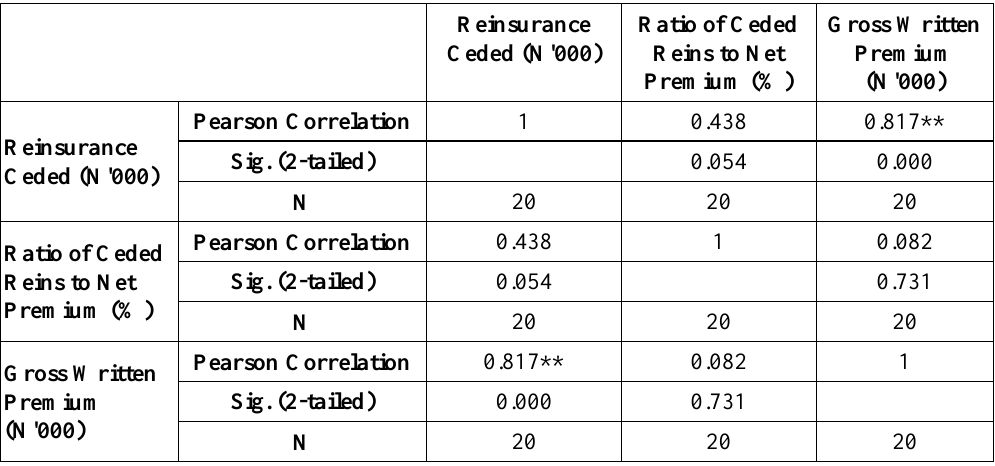
Table 1. Correlation Analysis of Reinsurance Capacity and